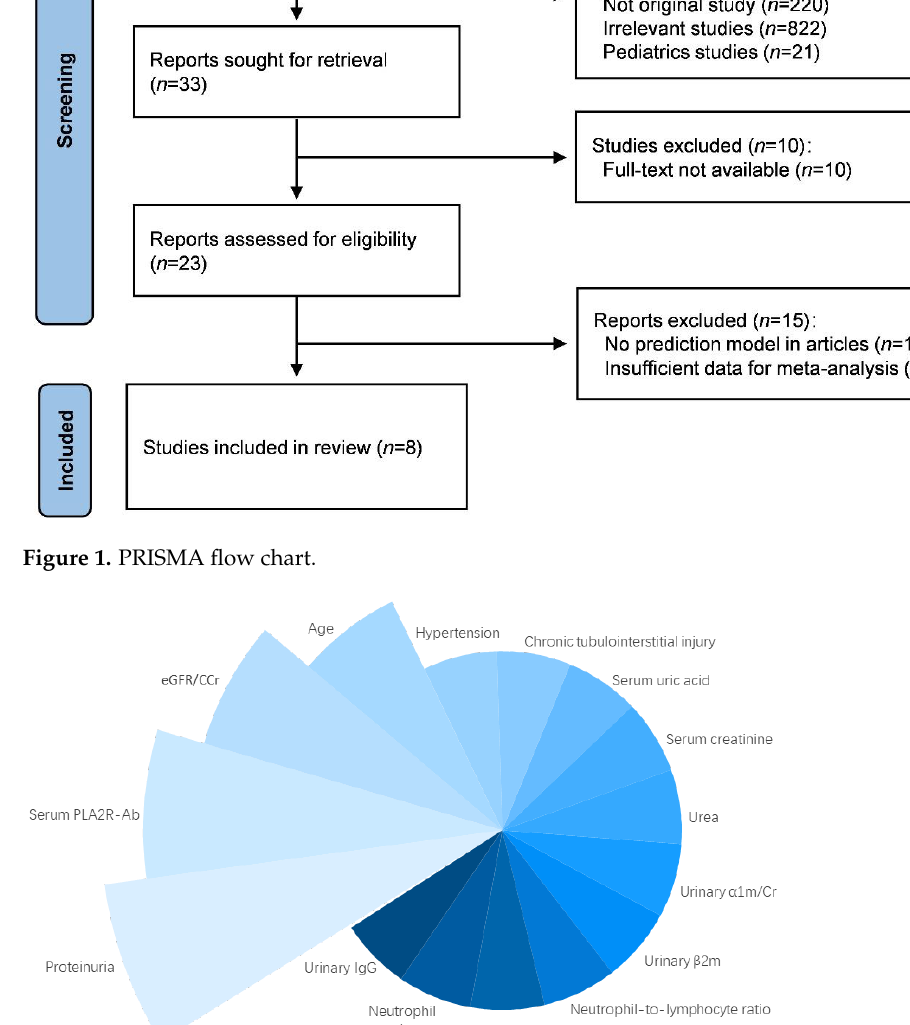
Figure 2. The frequencies of individual predictive variables in the included prediction models. Abbreviations: eGFR, estimated glomerular filtration rate; HDL-C, high-density lipoprotein choles- terol; PLA 2 R-Ab, PLA 2 R antibody; IgG, Immunoglobulin G; α1m/Cr, α1 -microglobulin corrected by creatinine; β2m, β2 -microglobulin.